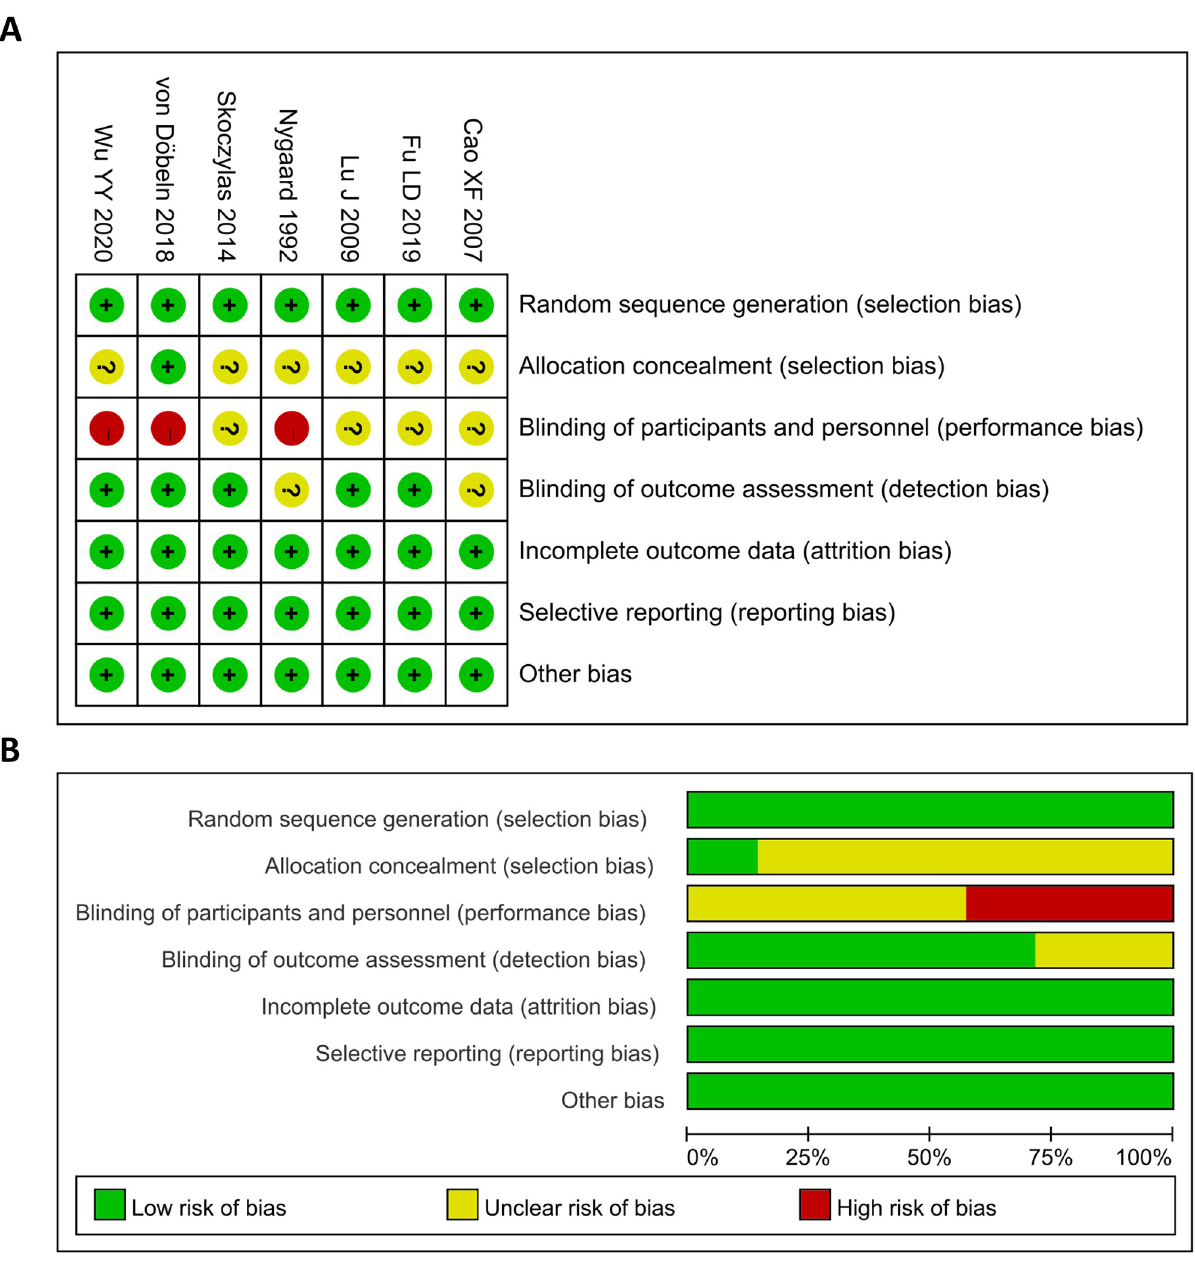
Fig 2. Risk of bias summary (A) and bias graph (B). Green indicates low risk; Red indicates high risk; Yellow indicates unknown